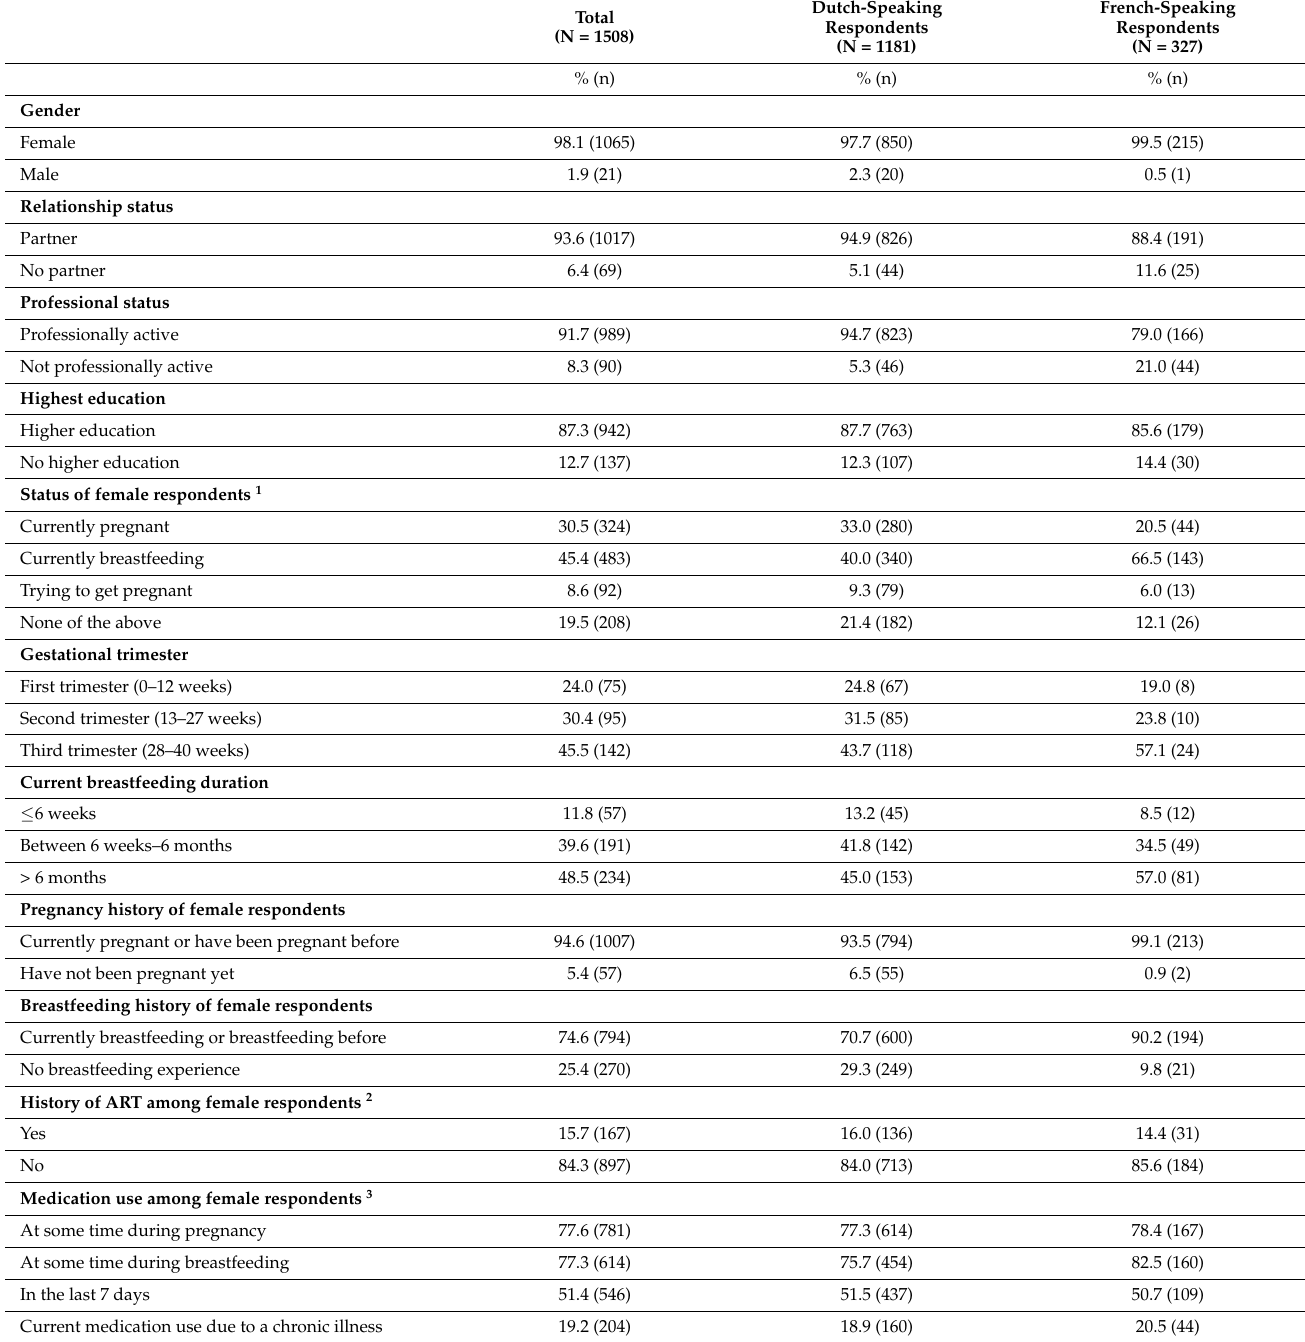
Table 1. Characteristics of the public survey participants according to the language of survey completion (N =